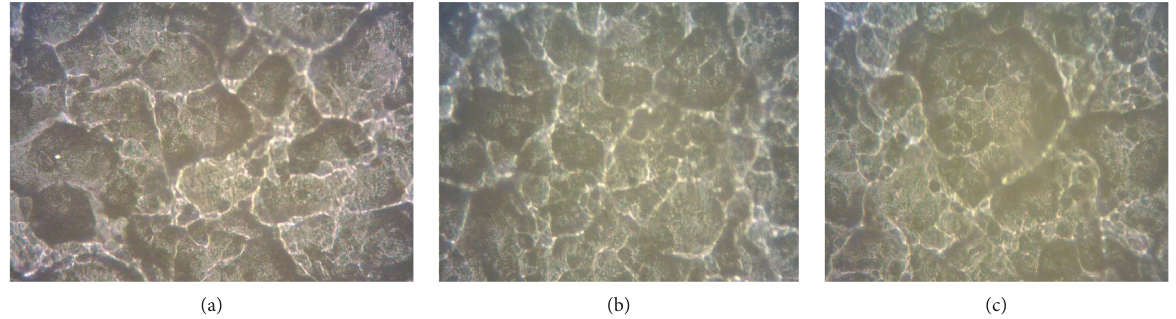
Figure 3: Optical microscope images for (a) PBS1, (b) PBS2, and (c) PBS3